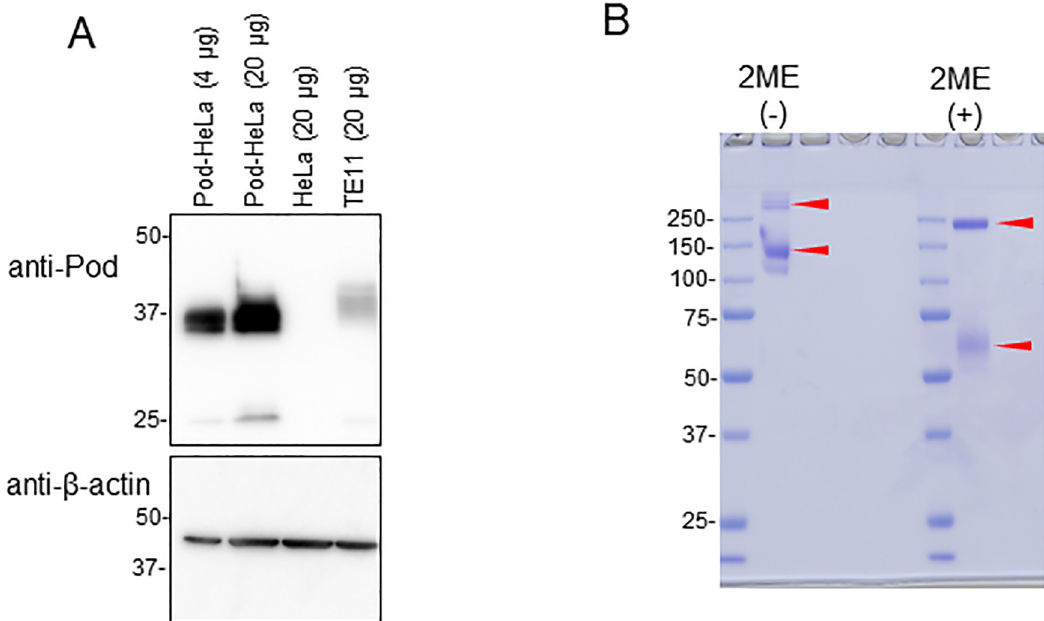
Fig 2. Level of podoplanin expression in HeLa cells and the purity of the Fc-CLEC-2 fusion protein. (A) Western blot analysis of podoplanin expression levels in pod-HeLa cells, parental HeLa cells, and TE11 cells. Triton X-100-soluble fractions from the indicated cells (4 μ g or 20 μ g) were analyzed by western blot for podoplanin expression levels. The aliquots were also analyzed for β - actin. (B) SDS-PAGE and Coomassie blue staining analysis of Fc-CLEC-2 molecules under reducing and non-reducing conditions with 2-mercaptoethanol (2ME). Red arrows indicate major bands. Data shown are a representative result from at least two independent experiments with similar results.